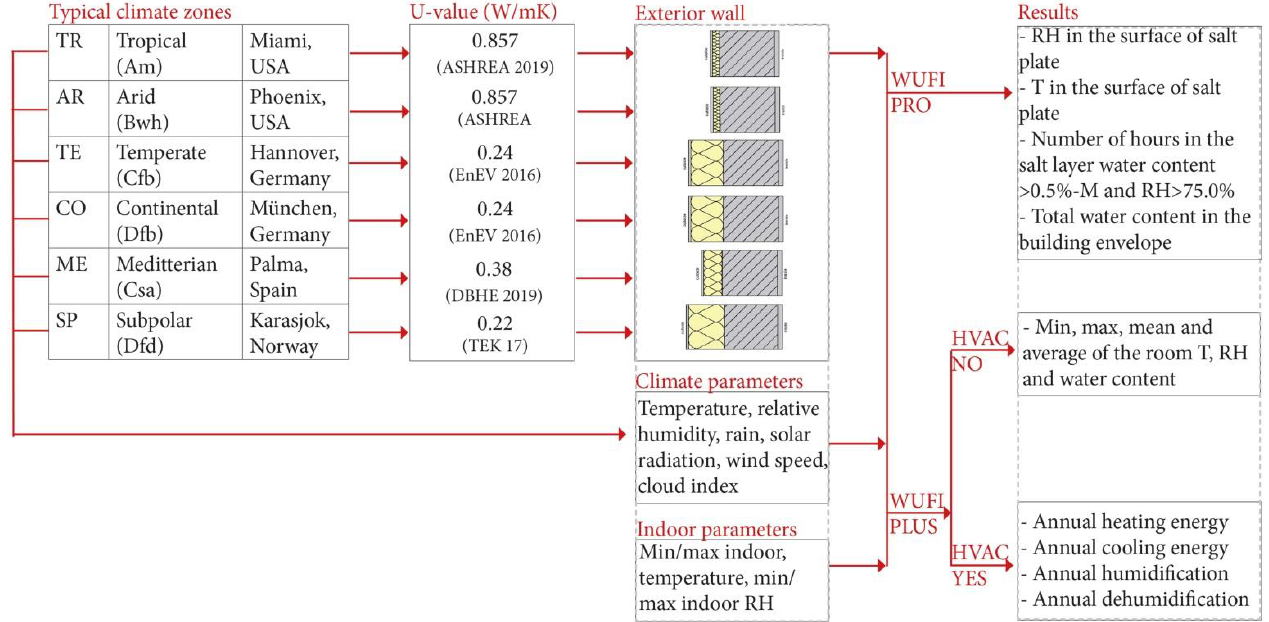
Figure 1. Simulation model design with the boundary conditions and expected results.